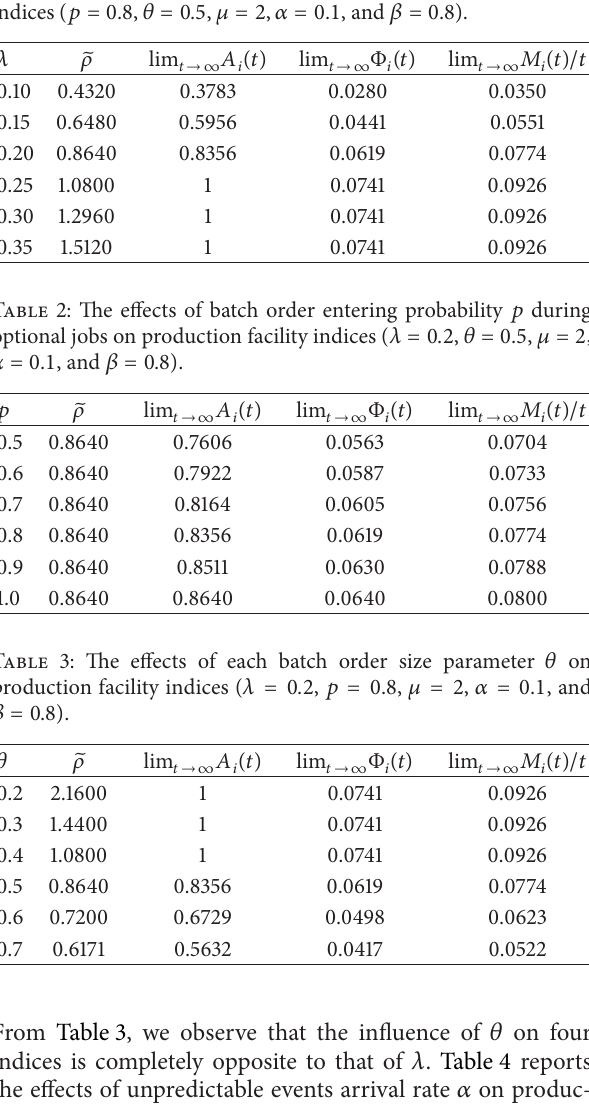
Table 1: The effects of batch order rate 𝜆 on production facility